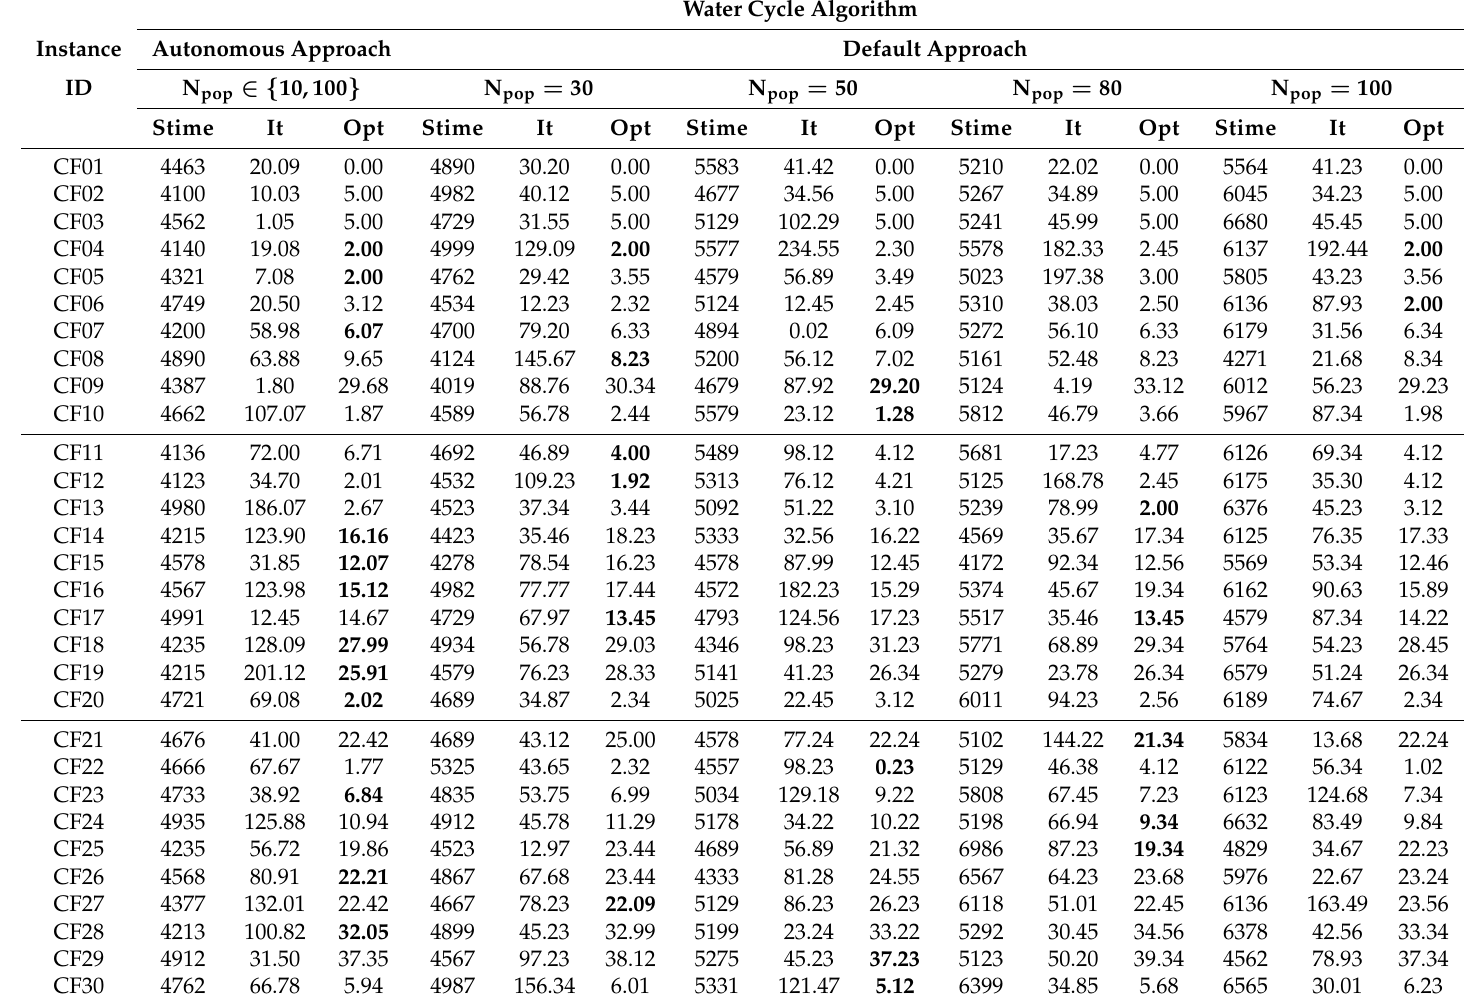
Table 9. Results solving complex instances